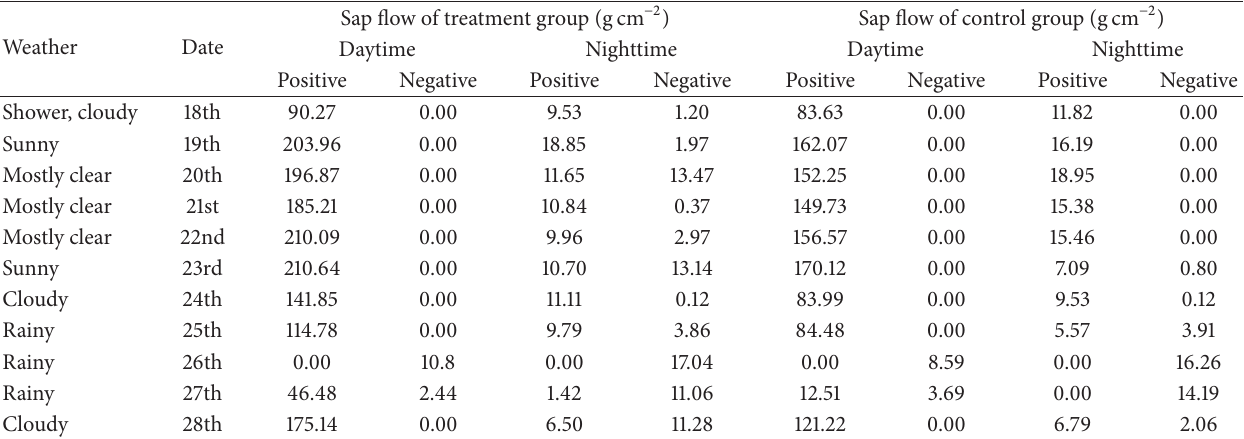
Table 2: Accumulated sap flow of T. ramosissima for treatment and control groups during the daytime and nighttime under different weather conditions in